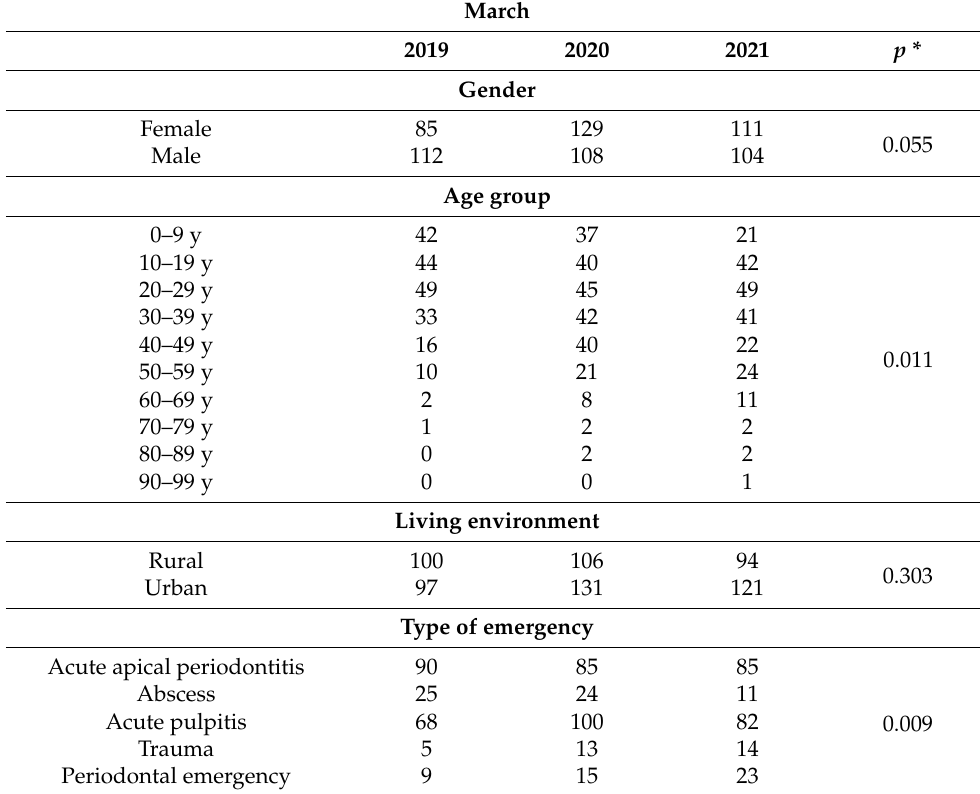
Table 3. Evolution for March 2019, 2020, and 2021 according to the investigated